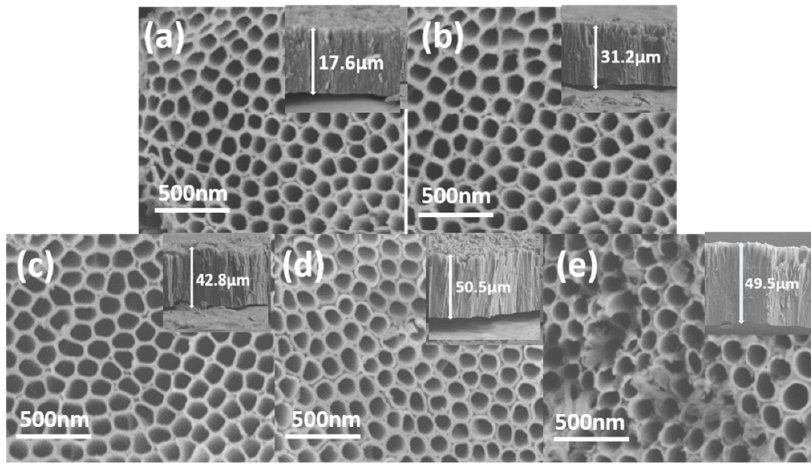
Figure 4. SEM images of TiO 2 nanotube arrays at different times. (a ) 6 h, ( b ) 8 h, ( c )10 h, ( d )12 h, and ( e )14 h.